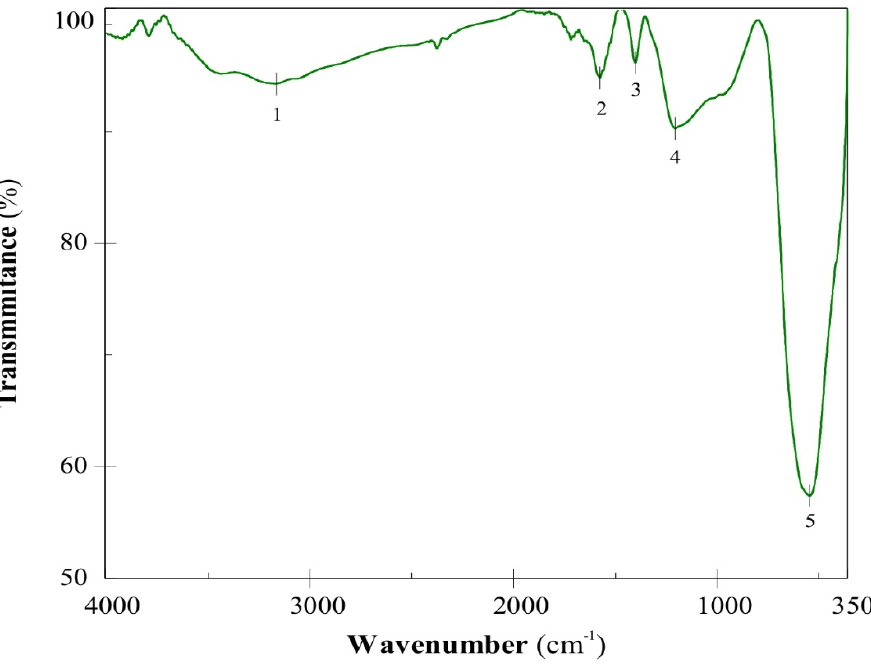
Figure 2. FT / IR spectrum of SnO-GO photocatalyst. Figure 2. FT/IR spectrum of SnO-GO photocatalyst.